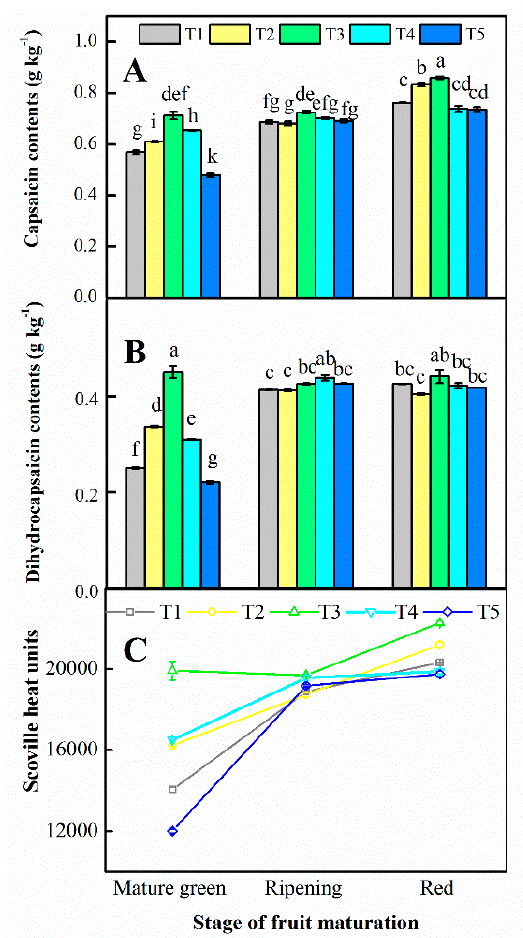
Figure 4. Capsaicin ( A ), dihydrocapsaicin ( B ) contents and Scoville heat units ( C ) in pepper fruit at the mature green, ripening, and red stage in response to di ff erent NH 4 + :NO 3 − ratios. Vertical bars represent mean ± SE ( n = 3, each replicate consisted of 12 pepper fruits) and the di ff erent letters denote significant di ff erences ( p < 0.05). The five treatments were defined in Figure 1 above.